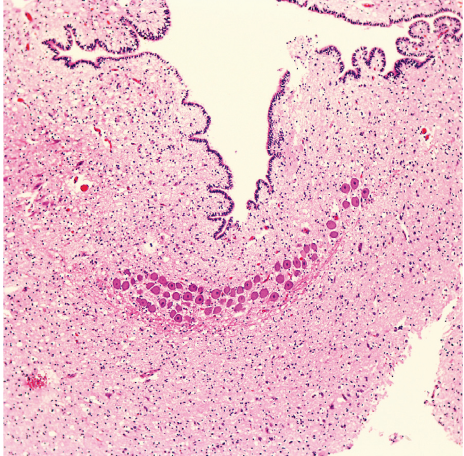
Figure 4: A rudimentary unilateral